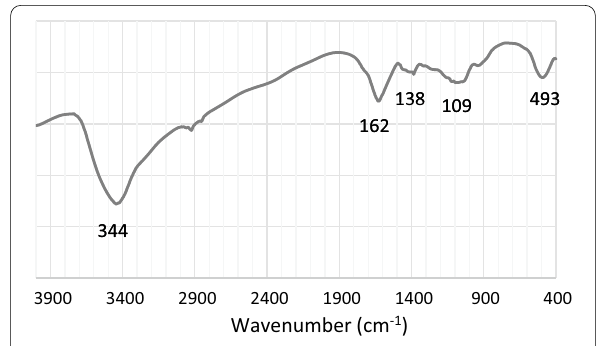
Fig.1 FT-IR spectra of Ch-NPs-TPP nanoparticles